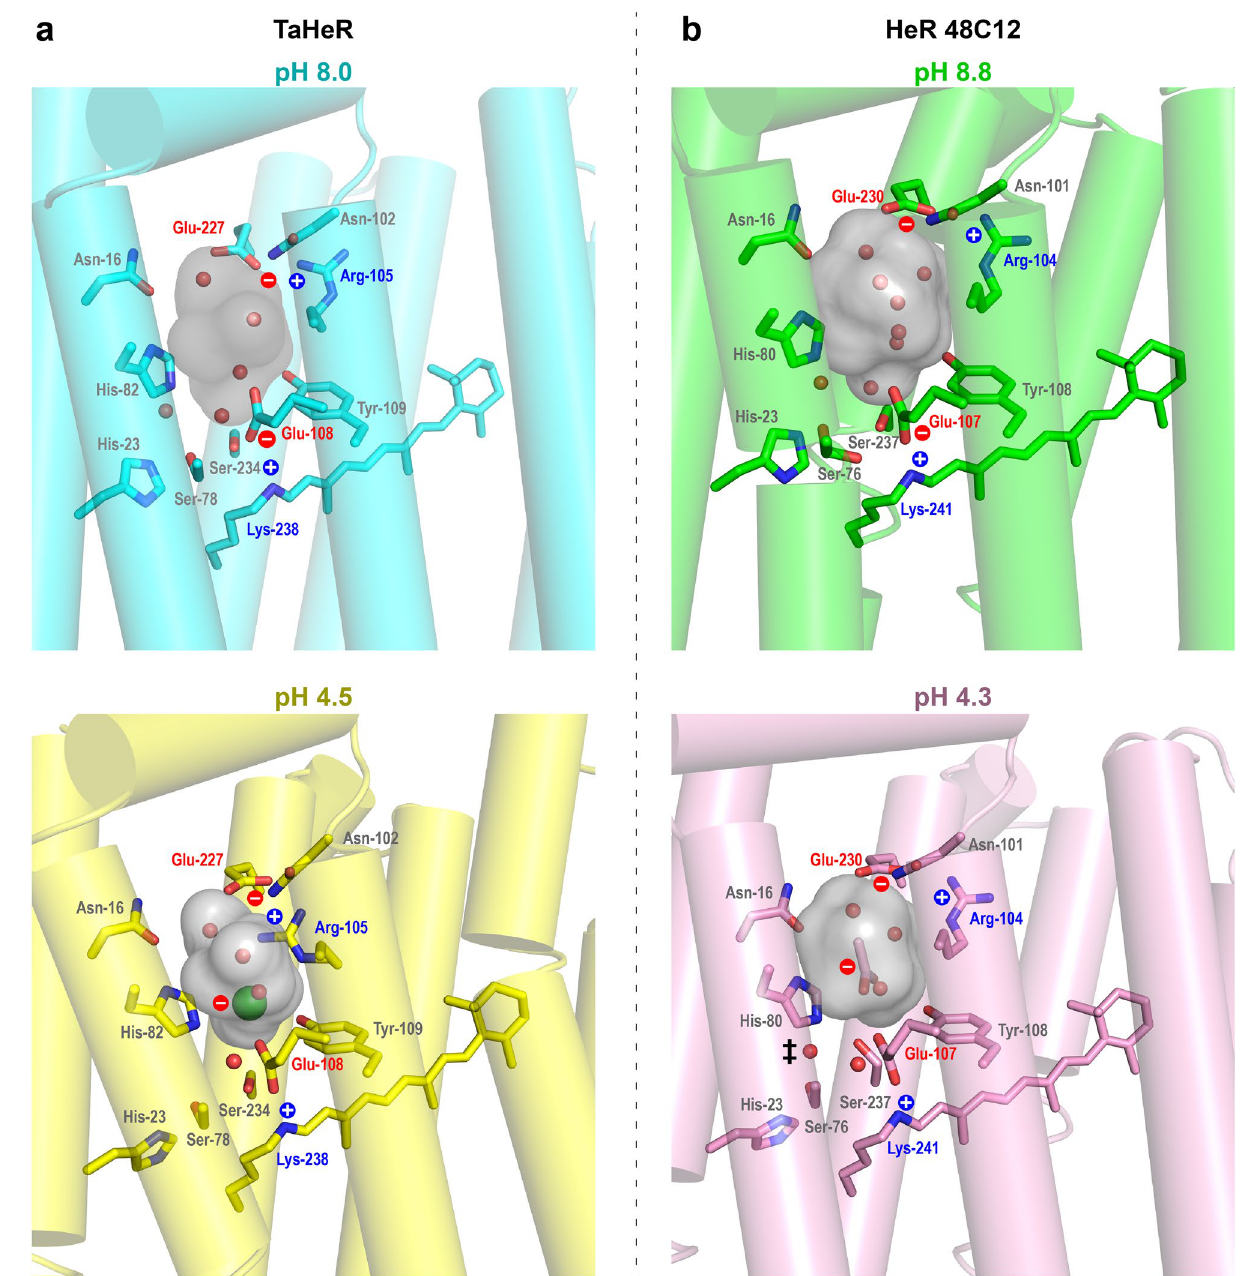
Figure 4. Schiff base cavity (SBC). SBC (grey surface) of ( a ) TaHeR and ( b ) HeR 48C12 under acidic and basic conditions. Under slightly basic conditions, the SBC of both TaHeR (PDB ID 6is6) and HeR 48C12 (PDB ID 6su3) contain only water molecules (red spheres) and are capped by two ionic interactions: (1) the RSBH + /Glu counterion pair and (2) the Arg/Glu pair. Under acidic conditions, the Glu counterion accepts a proton and is neutral. The SBC of TaHeR accommodates a negatively charged chloride ion (green sphere) while HeR 48C12 (PDB ID 6su4) accommodates a negatively charged acetate ion to maintain charge balance with the RSBH + . The negative charges are indicated by red dashes, while the positive charges are shown by blue pluses. ‡ Weak electron density adjacent to Ser-76 in the pH 4.3 HeR 48C12 structure has been modeled as a water molecule, but this molecule may also be absent, as in